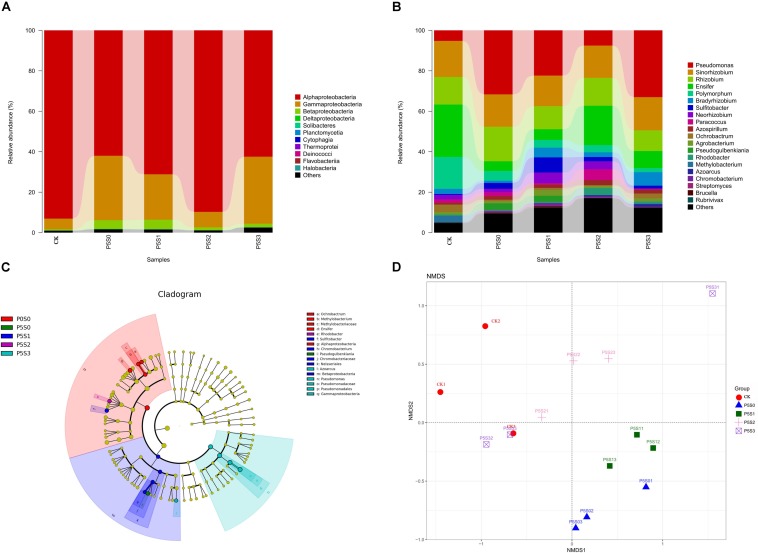
Taxonomic composition of norB-type denitrifying bacterial communities at the (A) class and (B) genus levels in rhizosphere soil of C. illinoinensis seedlings in CK treatment and in different SNP treatments under low P stress. (C) Cladogram based on linear discriminant analysis effect size (LEfSe) analysis (P < 0.05, LDA score > 2) showing significant differences in abundance of norB-type denitrifying bacterial taxa in different groups; (D) non-metric multidimensional scaling (NMDS) analysis of norB-type denitrifying bacterial communities in rhizosphere soil of C. illinoinensis seedlings with different treatments. All treatments were had three replicates. CK, rhizosphere soil of uninoculated C. illinoinensis seedlings that received 0 μmol/L SNP and P application. P5S0, P5S1, P5S2, and P5S3 represent the rhizosphere soil of C. illinoinensis seedlings colonized by T. indicum and treated with 0, 10, 100, and 1000 μmol/L SNP, respectively, under low P stress (5 μmol/L).